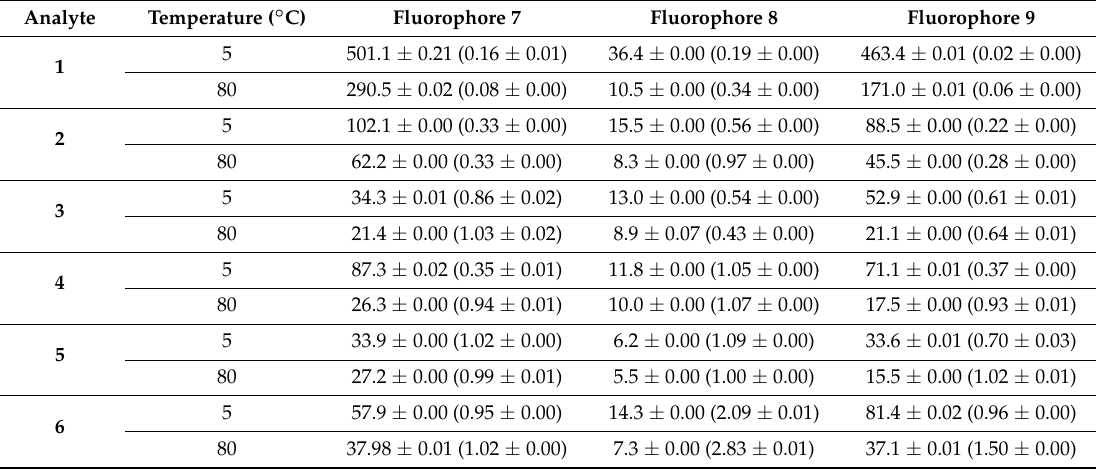
a Results represent the average of four trials; energy-transfer efficiencies were calculated using Equation (1); control ratios were calculated using Equation (2).